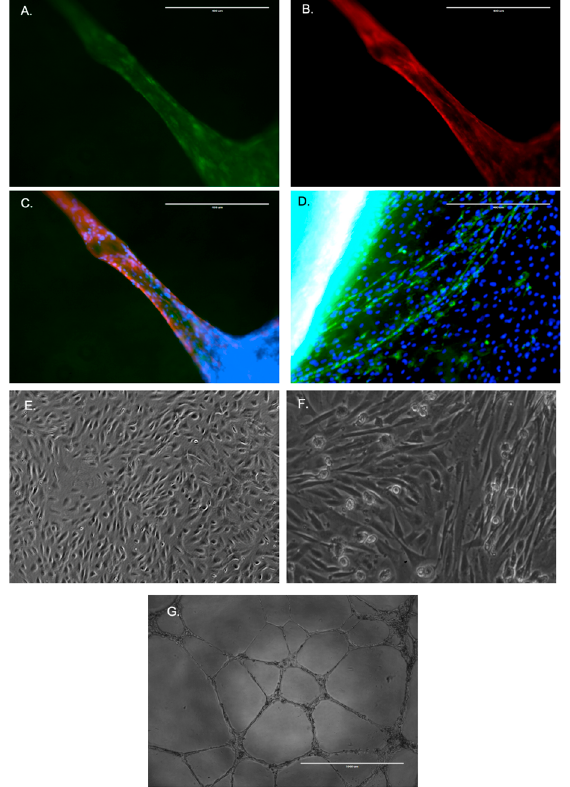
Figure 2. The formation of a new vessel from fetal VSCs. ( A ) The endothelial layer staining by lectin. ( B ) The alpha-smooth muscle actin staining by RFP conjugated antibodies. ( C ) The combined image of smooth muscle cells (red), endothelial cells (green), and cell nuclei (blue) by DAPI live cell stain. ( D ) The staining of sprouting angiogenesis from adult vessel segment and the presence of the endothelial cell layer (green). No alpha-smooth muscle stain (red) was observed. ( E ) The morphology of purified endothelial cells by CD31 antibodies-mediated pull down. ( F ) The morphology of FVSCS. ( G ) The tube formation by purified endothelial cells on a 3D gel matrix. All of the images shown in the figure were taken at 10 ×